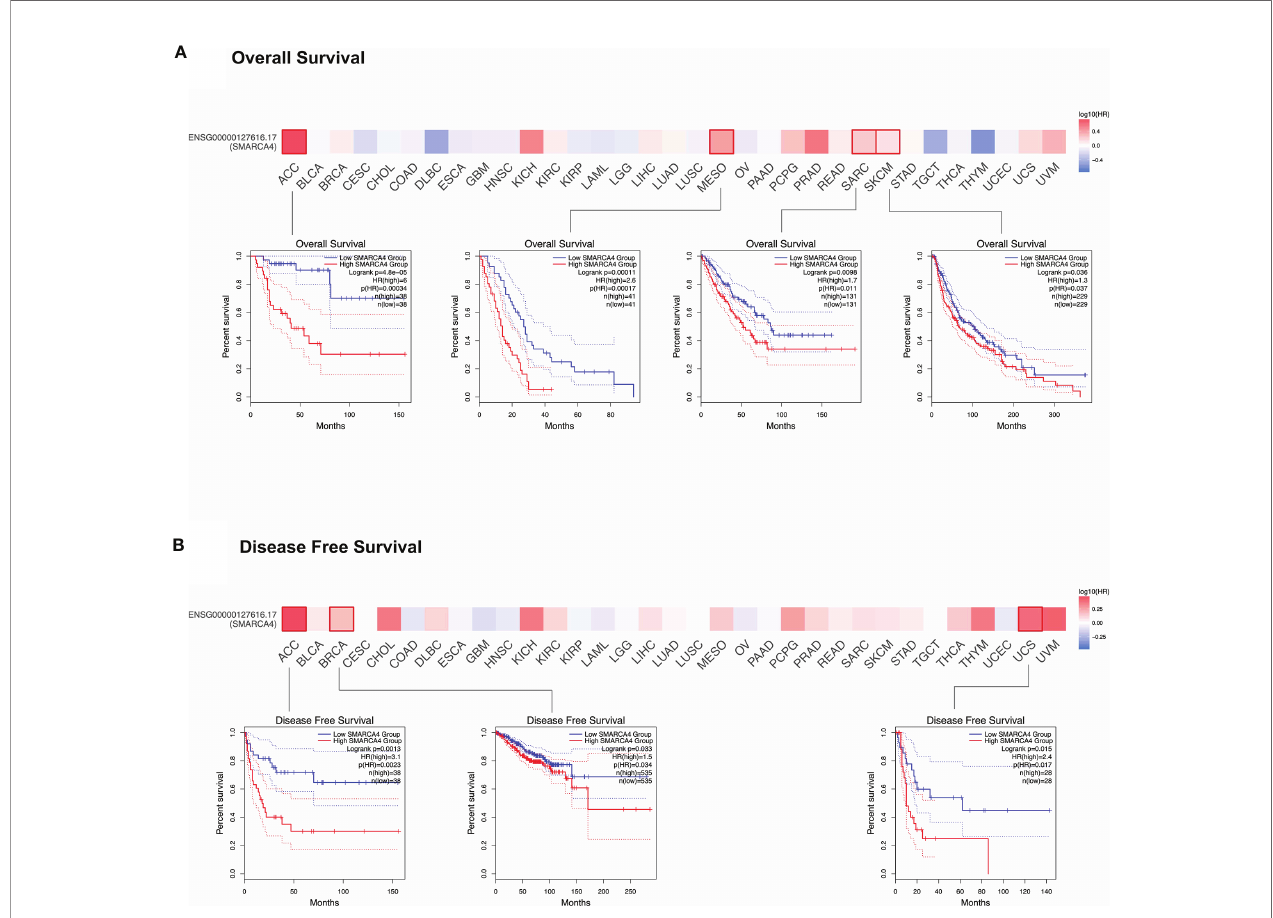
FIGURE 2 | Correlation between SMARCA4 gene expression and survival prognosis of cancers in TCGA. GEPIA2 tool was used to perform overall survival (A) and disease-free survival (B) analyses of different tumors in TCGA by SMARCA4 gene expression. The survival map and Kaplan-Meier curves with positive results are